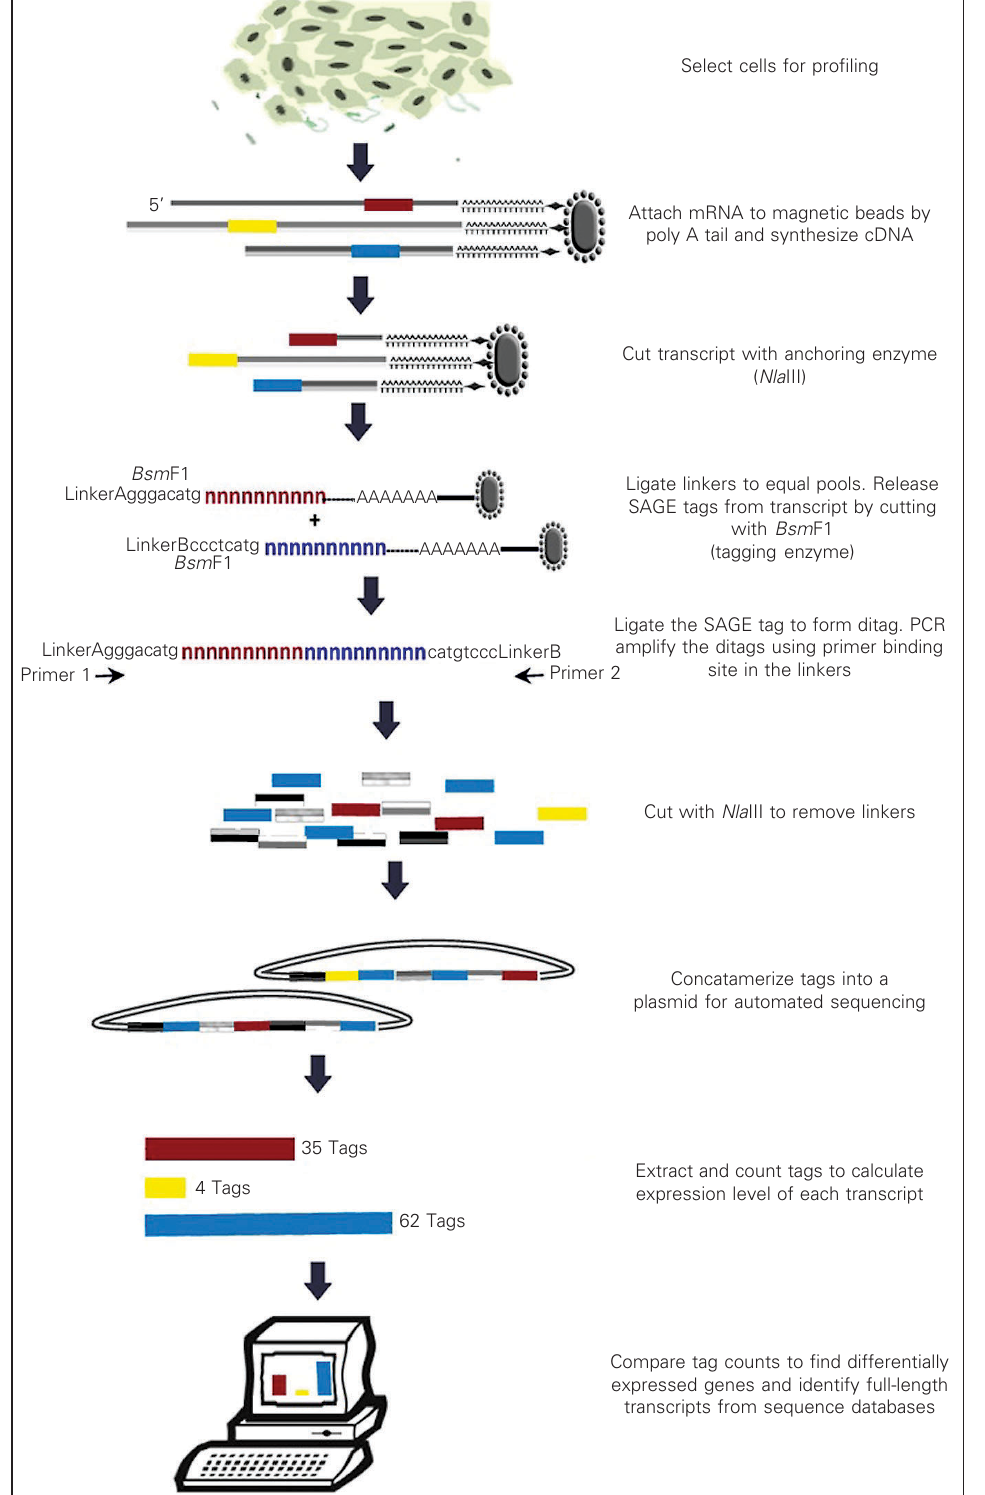
Figure 1. The principle of serial analysis of gene expression (SAGE). Gene expression pro- files are determined from cells of interest by first capturing their mRNA using oligo-dT-coated beads and then preparing the cDNA. The anchoring enzyme Nla III is used to cleave cDNA that remains attached to the beads. Linkers, which contain a site for tagging enzyme Bsm F1 and primers, are ligated to the cDNA. The Bsm F1 is used to release a short tag. These tags are paired into ditags, amplified by PCR, cut with Nla III, ligated to form concatamers, and cloned into a sequencing vector for efficient counting on an auto- mated sequencer. Tag counts from each tissue type are stored electronically and used for com- parison to other cell populations. The relative fraction of each tran- script can be calculated as well. Informatics is used to match the SAGE tag to a known gene or expressed sequence